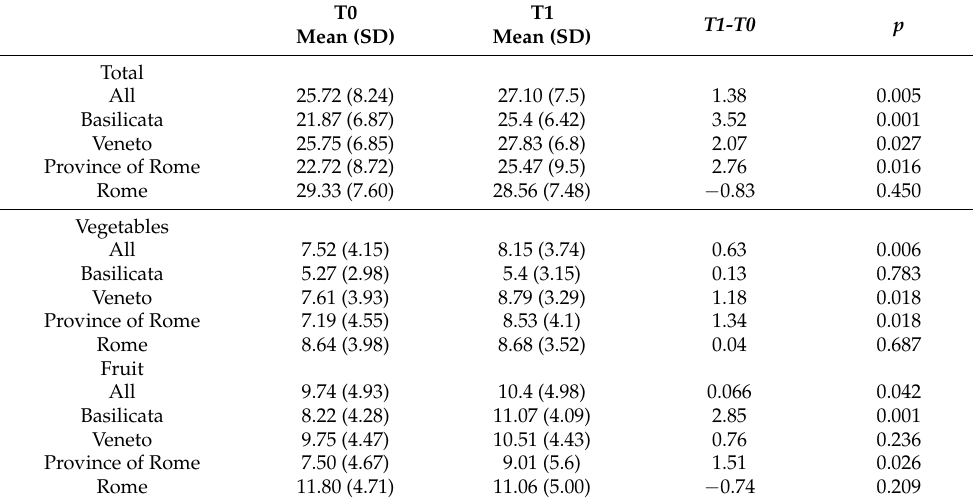
Table 5. Weekly Food Plan (WFP) evaluation. Total score and single score considering vegetable and fruit servings independently, obtained by the students by compiling a weekly menu plan before (T0) and after